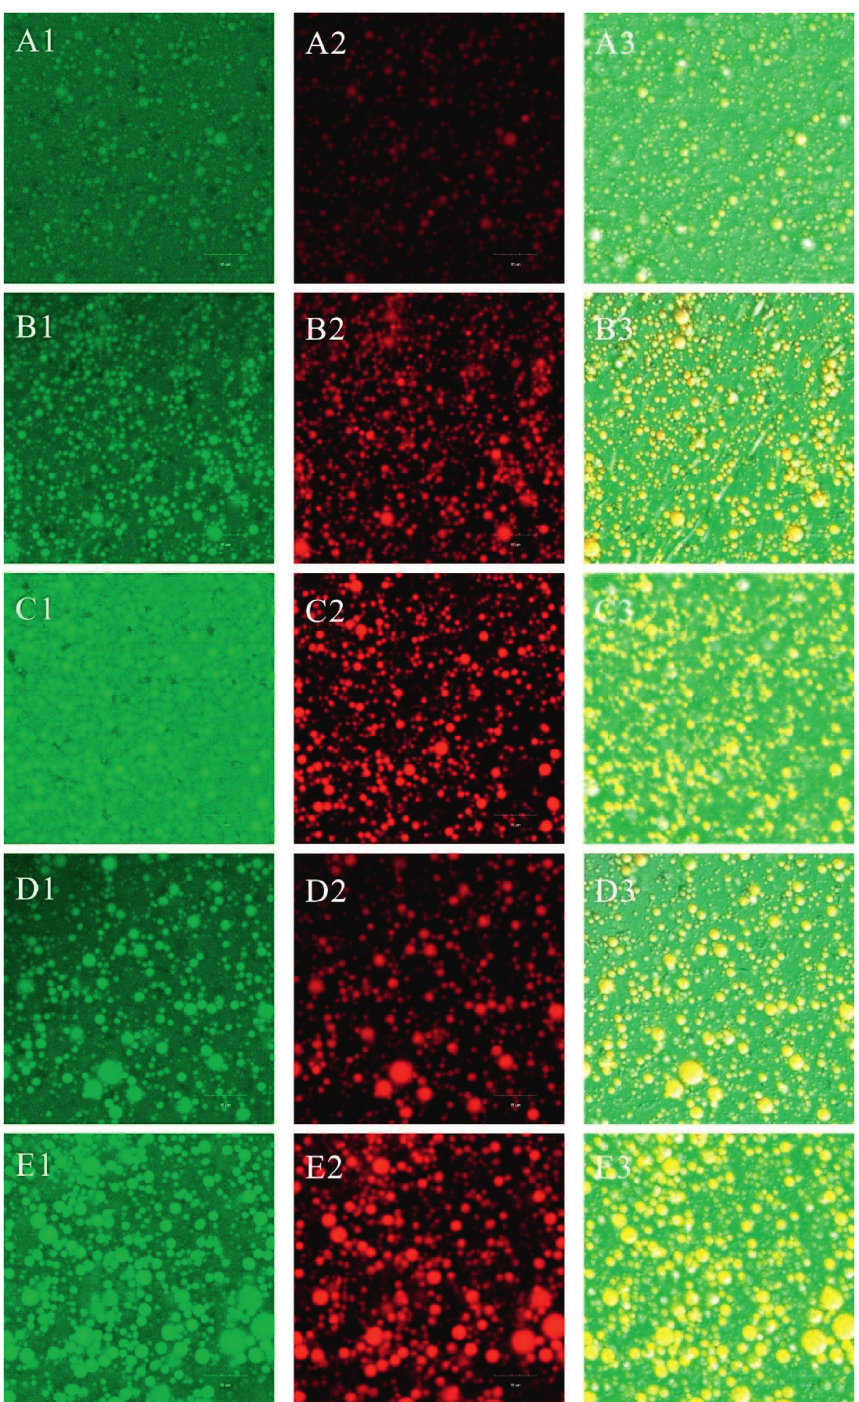
Figure 7: CLSM images of the peanut oil body microstructure under different pH conditions. (a–e) pH 6.8, 8, 9, 10, and 11, respectively; 1 denotes protein stained green, 2 denotes oil stained red, and 3 denotes oil bodies with oil and protein). According to the previous ex- perimental methods, oil body suspensions were mixed with Nile Red (excitation 561 nm, emission 588 nm) to stain neutral lipids and FITC (excitation 488 nm, emission 517 nm) to stain proteins. In the CLSM results, the oil located in the core of the oil body was labeled with Nile Red to emit red fluorescence, and the protein at the oil body interface was labeled with FITC to emit green